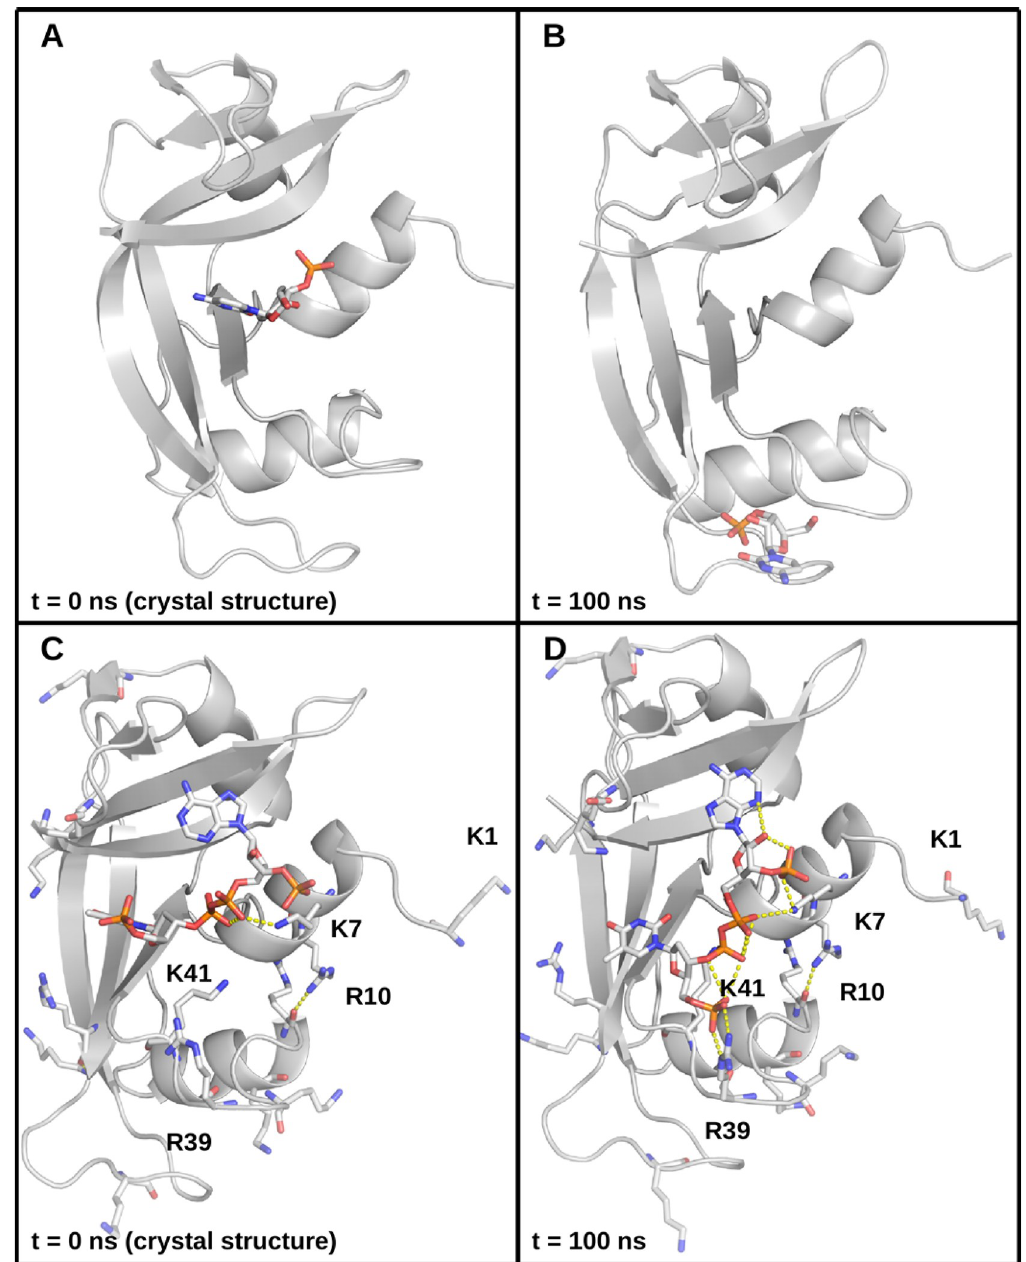
Fig 3. Comparison between crystal and simulated structures. (A) The RNase A–C3P complex from a crystal structure. The protein backbone is in cartoon representation, colored in gray, the ligand is given in stick representation with carbon atoms in white, nitrogens in blue, oxygens in red, and phosphorus in orange. (B) The RNase A–C3P complex after 100 ns of production dynamics. (C) The RNase A–PAX complex from a crystal structure. The protein backbone is in cartoon representation, colored in gray. Lysines, arginines, and the ligand are given in stick representation with carbon atoms in white, nitrogens in blue, oxygens in red, and phosphorus in orange. Certain lysine and arginine residues are labeled; polar contacts are shown as dotted lines. (D) The RNase A–PAX complex after 100 ns of production